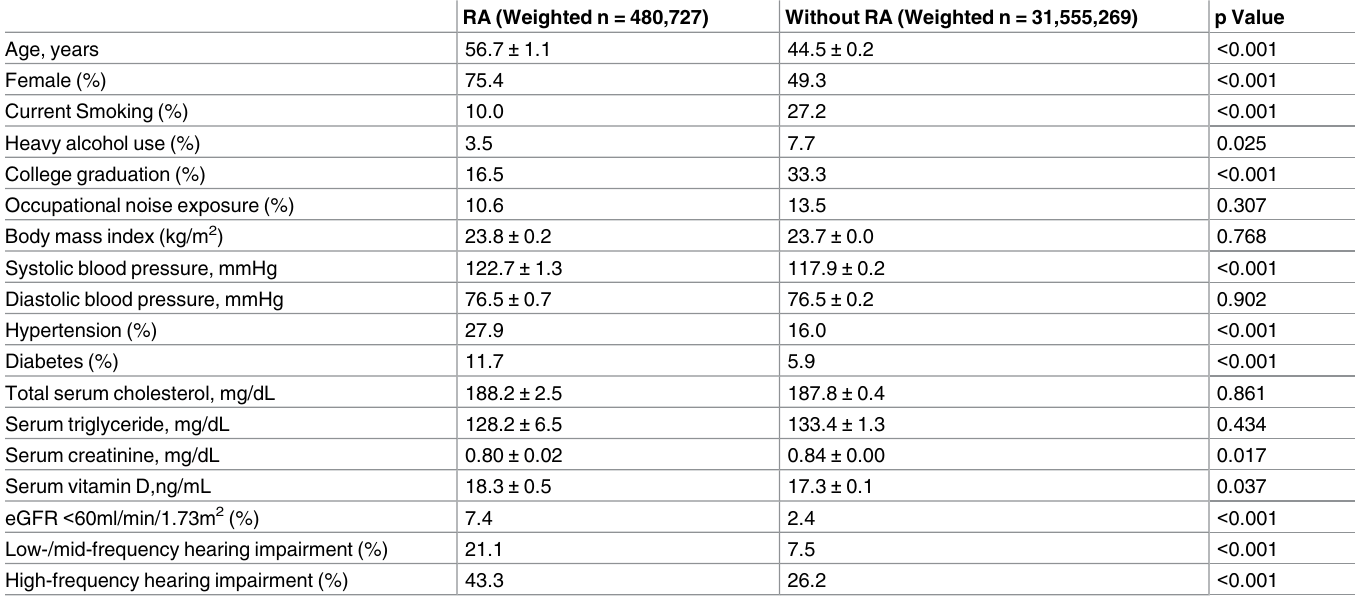
Table 2. Demographic and clinical characteristics according to the presenceor absence of RA in the Korean adult population (2010–2012